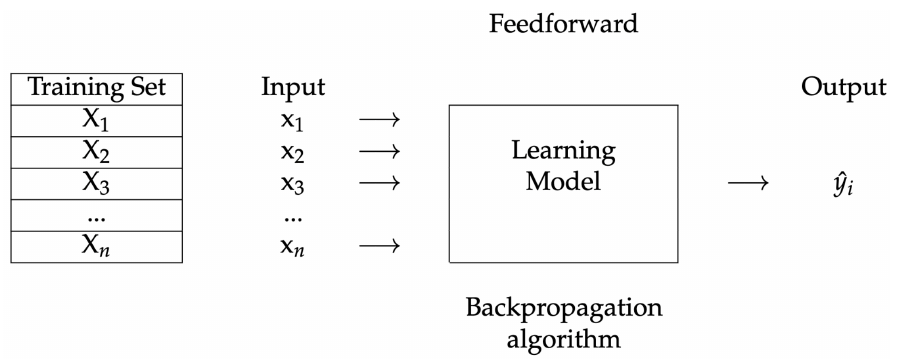
Figure 1. Illustration about the machine learning model’s setup. Stars form a training set used for the tuning